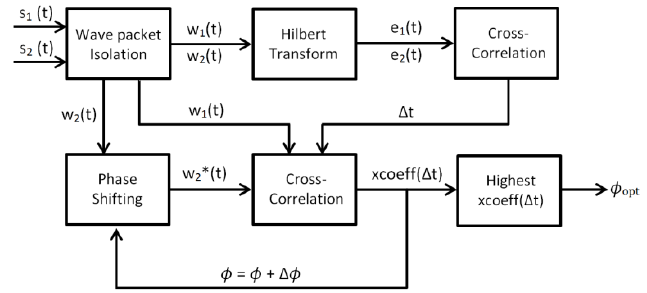
Figure 3. Methodology’s block diagram to extract the optimum phase shift and time delay.